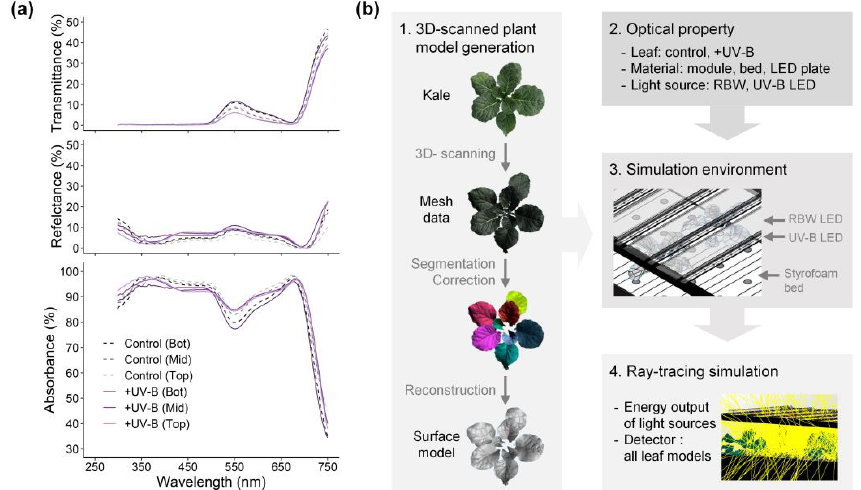
Figure 6. ( a ) Optical properties of kale leaves measured individually at the top (Top), middle (Mid), and bottom (Bot) of the plant in each treatment with three replicates; ( b ) Schematic diagram of radiation interception analysis from 3D scanning to